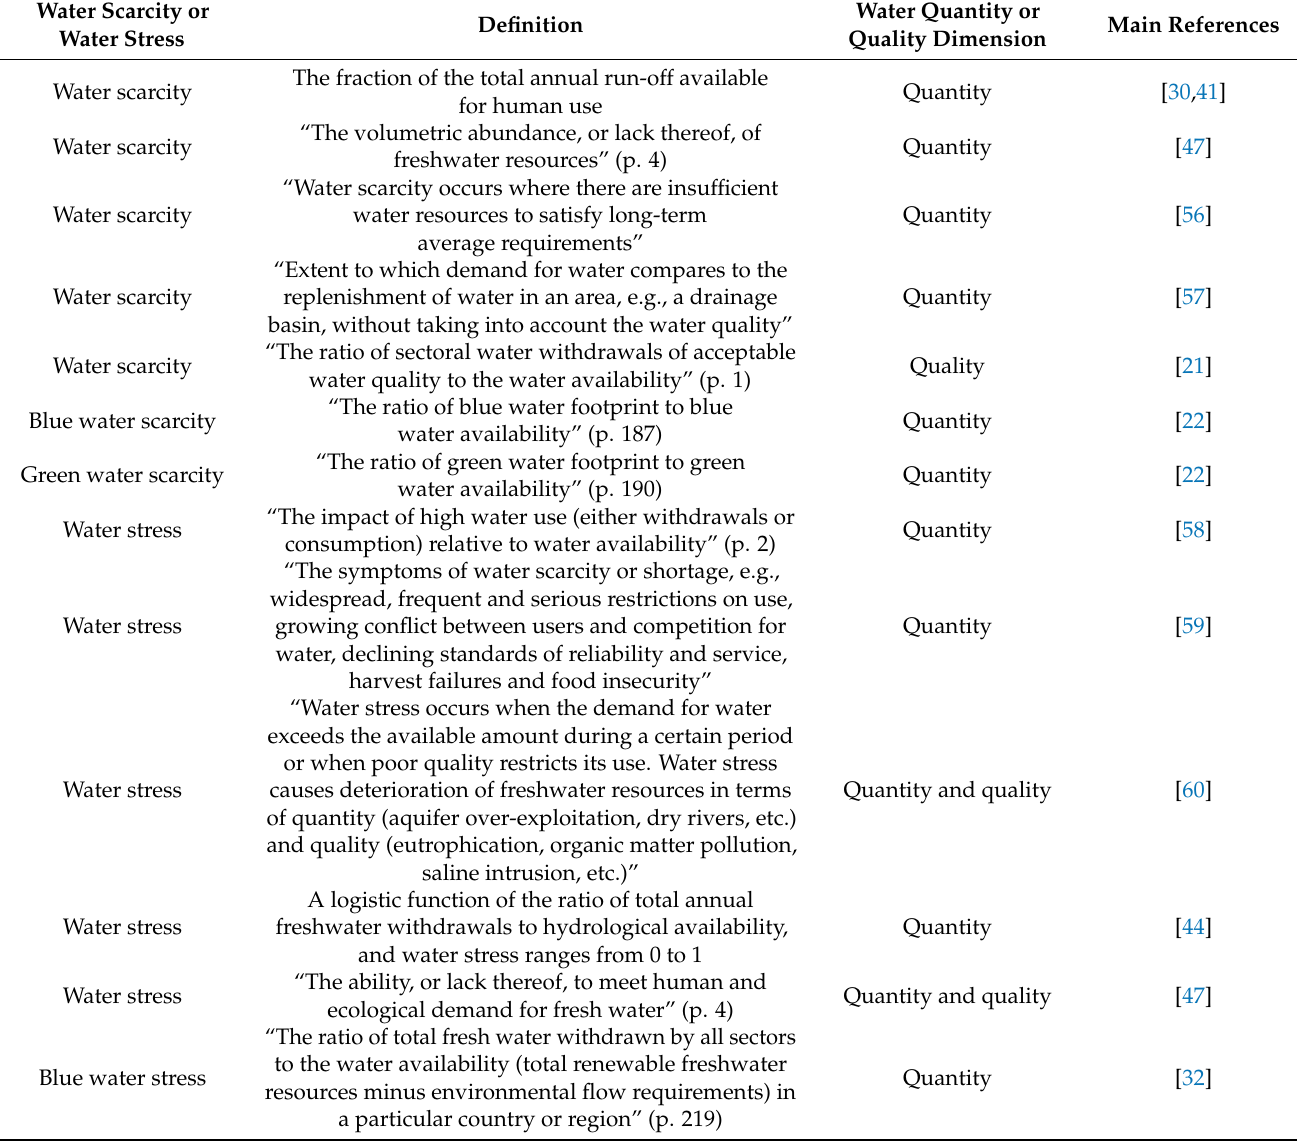
Table 1. Definitions of physical water stress and